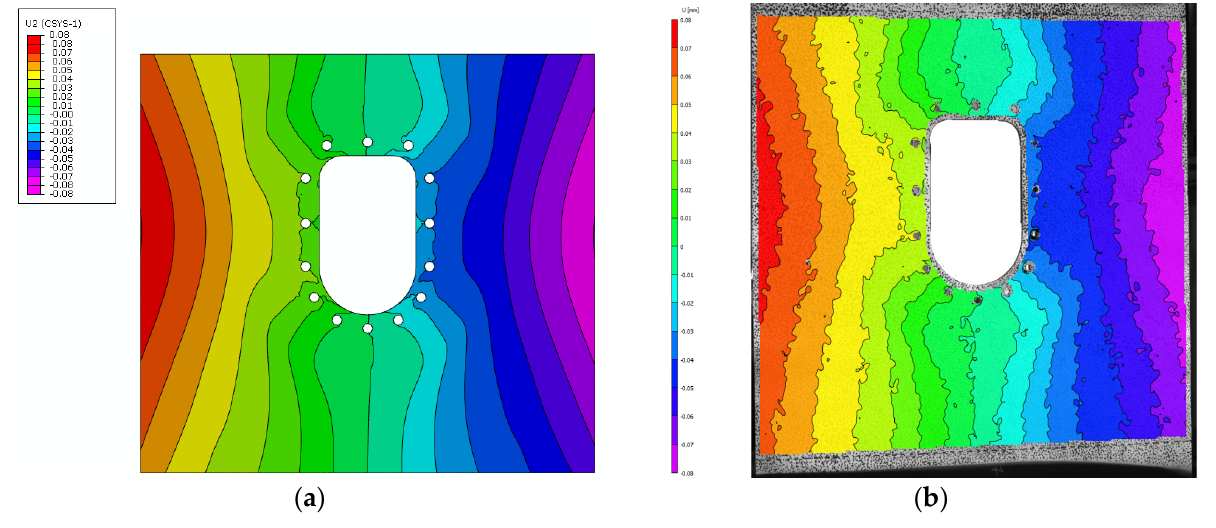
Figure 23. ( a ) Contours of displacement perpendicular to the loading direction according to FE analysis and ( b ) contours of displacement perpendicular to the loading direction according to DIC.